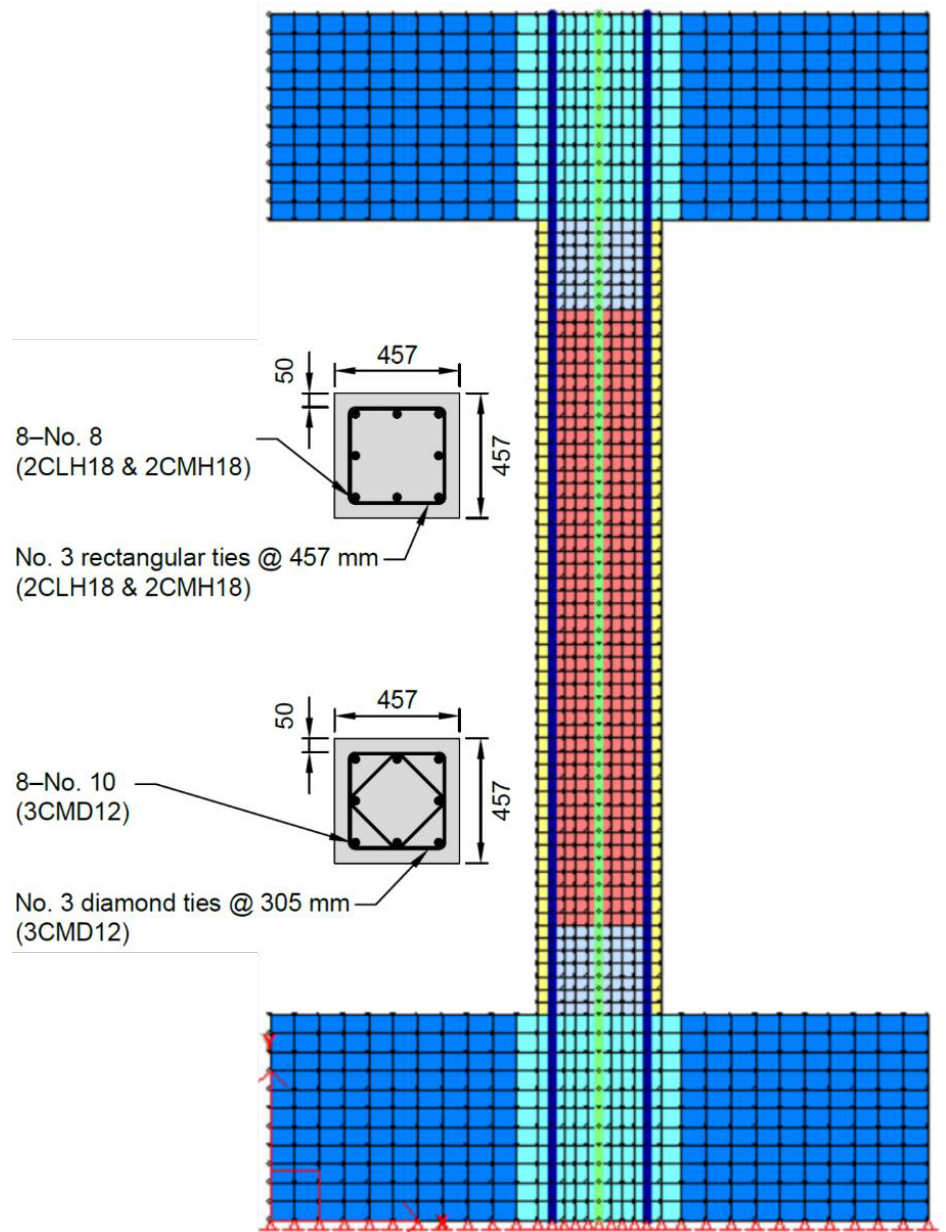
Figure 10. Example of finite element model and typical cross-sections of columns tested by Lynn et al. [15]. Column 2CMH18 experienced a brittle shear failure during the last cycle at a displace- ment of 30 mm. The failure occurred due to the formation of an inclined crack and yielding of the tie crossing the crack. Longitudinal reinforcement at the column base had yielded just prior to failure but flexural hinging had not occurred. The finite element analysis gives reasonable predictions of the column shear-displacement response, and correctly predicted that a brittle shear failure would occur (see Figure 11c). The analysis also predicts that the longitudinal reinforcement just reaches yield at a displacement of 30 mm. The predicted strength was 301 kN compared with the experimental strength of 306